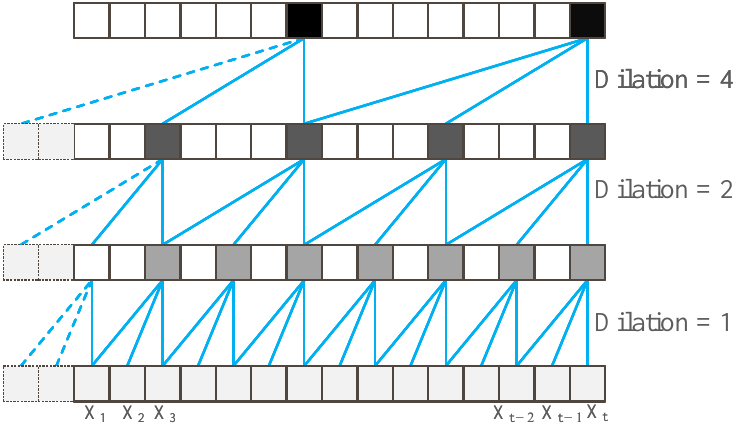
Figure 1. The dilated causal